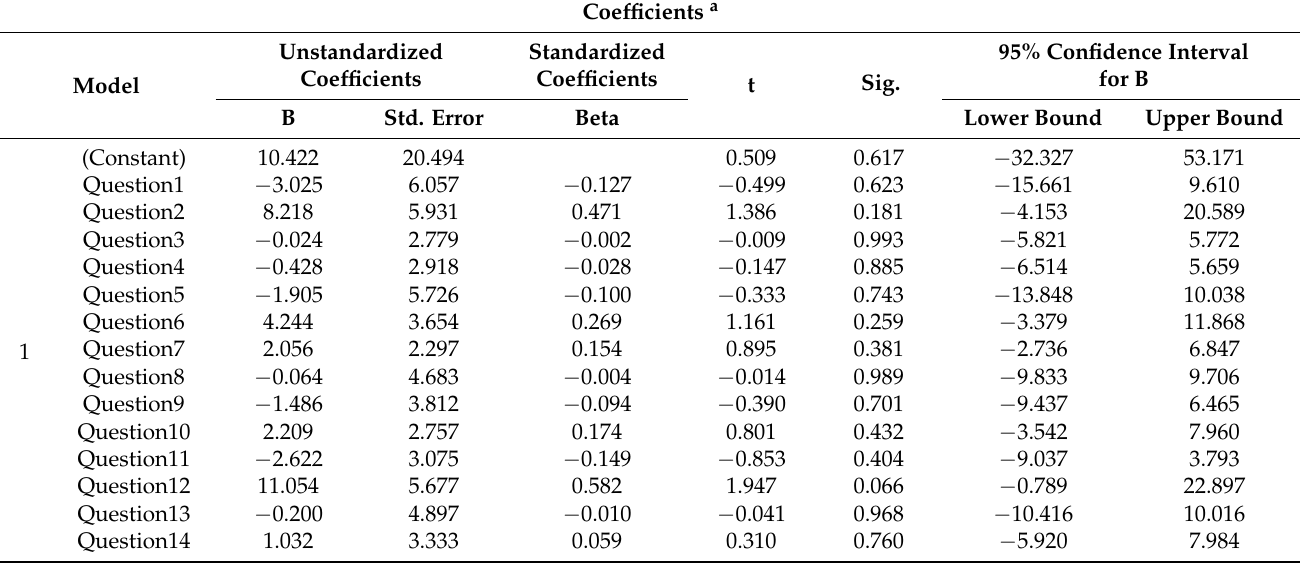
Table 4. Regression table for the variables of the